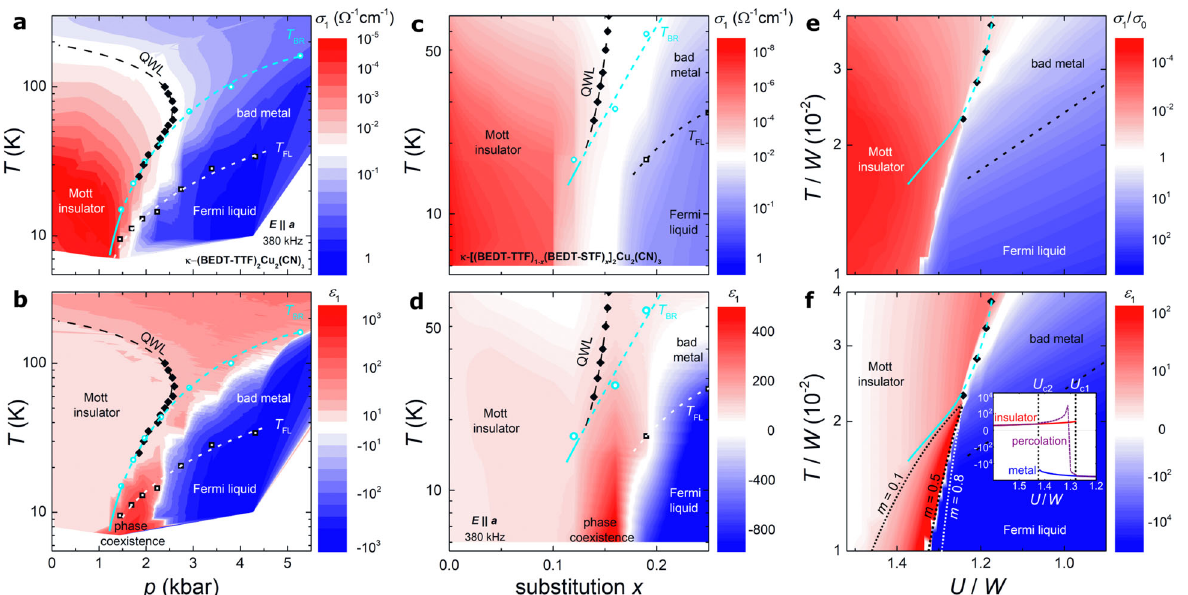
Fig. 4 Phase diagram of κ -(BEDT-TTF) 2 Cu 2 (CN) 3 when tuned through the Mott IMT. Both conductivity and permittivity exhibit similar behavior upon varying correlation strength U / W by a , b physical pressure or c , d chemical substitution, which is reproduced by e , f our hybrid DMFT calculations; the respective color codes are given to the right. In all cases, the colossal enhancement of ε 1 reveals a sharply de fi ned insulator-metal phase-coexistence region around the fi rst-order IMT, which is not seen in σ 1 . The permittivity clearly distinguishes the Mott- insulating and metallic states via small positive and large negative values, which line up perfectly with the quantum Widom line (QWL) and the Brinkman-Rice temperature T BR determined from σ 1 ( T , p , x ), respectively. Inset of f : metallic and insulating DMFT solutions are contrasted to the mixed phase (metallic fractions m indicated in main panel) that reproduces the strong peak in ε 1 . Note, T BR is indicated by a dashed cyan line at T > T crit in all panels; the resistivity maxima below T crit (solid cyan line) arise due to percolative